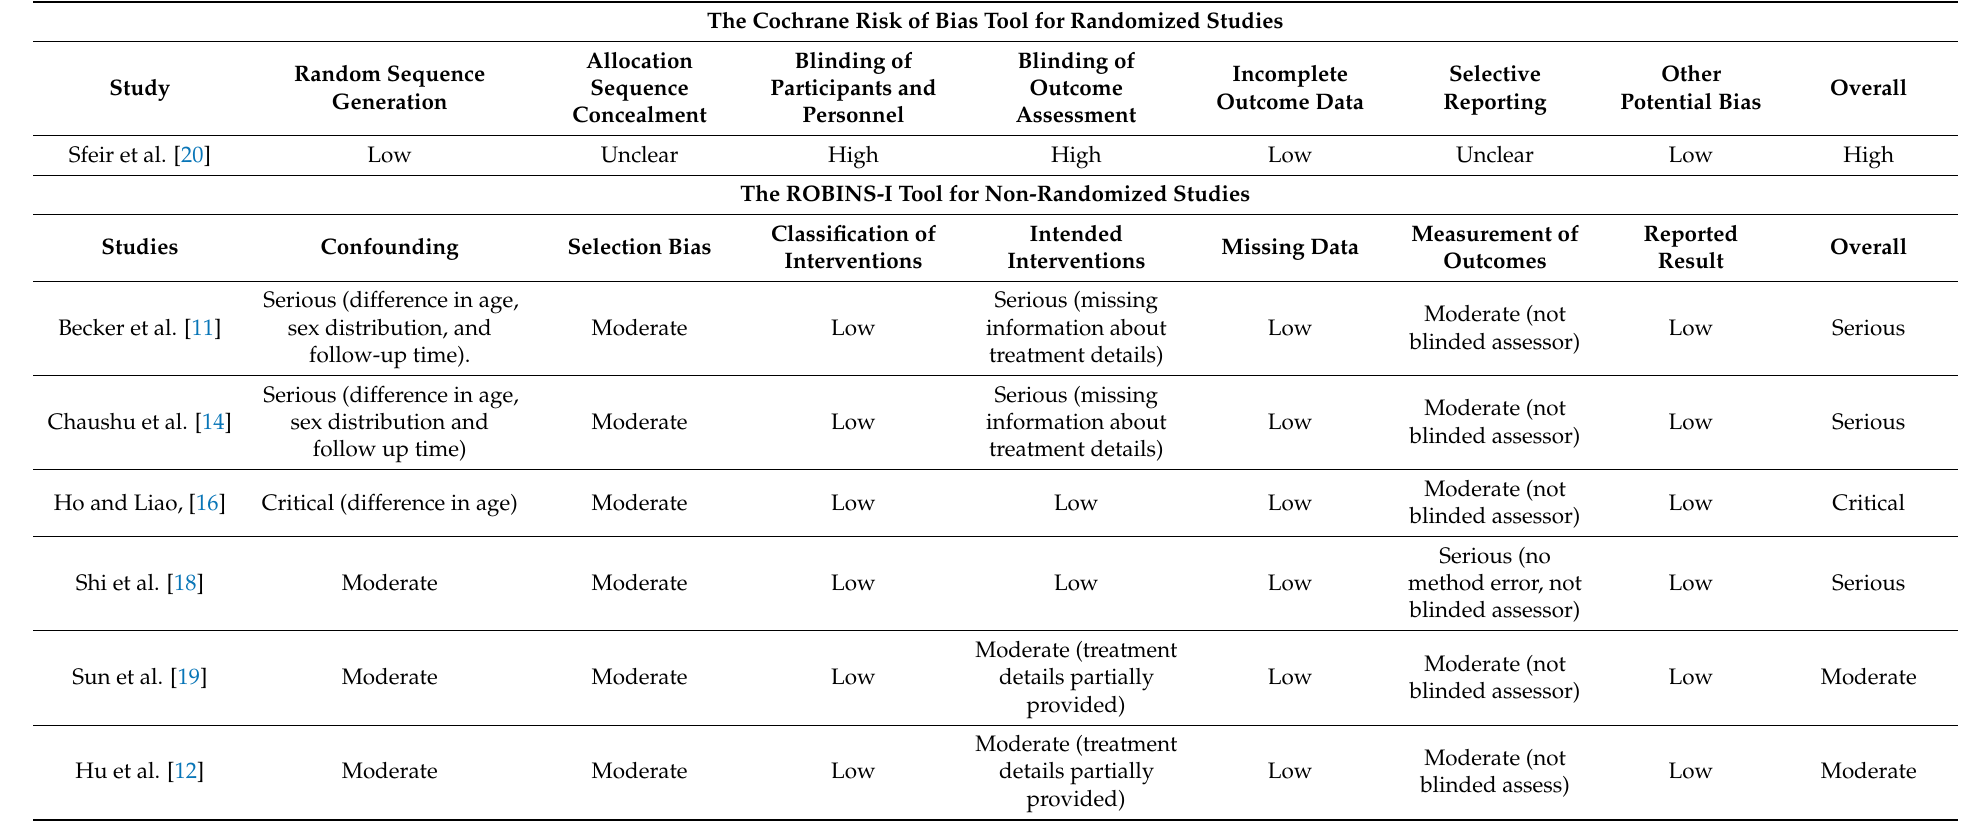
Table 2. Summary of risk of bias assessment for randomized study (Cochrane risk-of-bias tool) and risk of bias assessment for non-randomized study (the ROBINS-I tool). The Cochrane Risk of Bias Tool for Randomized